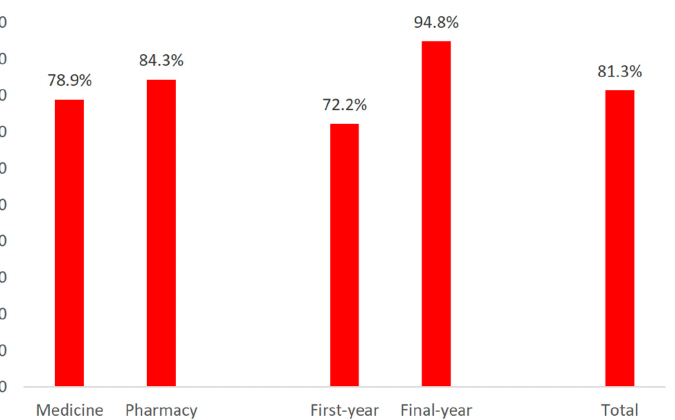
Figure 1. Self-medication prevalence among first- and last-year medicine and pharmacy students. The responses of the first- and final-year pharmacy and medicine students to the question of the main reasons for their self-medication behavior in the previous year are shown in Table 2. The most common reason why students did not self-medicate was the fact that they did not have a need for self-medication (70.3%), while fewer students were concerned about the safety of taking drugs self-initiatively (29.7%). Out of 156 students who reported self-medication, the majority indicated mild symptoms that did not require